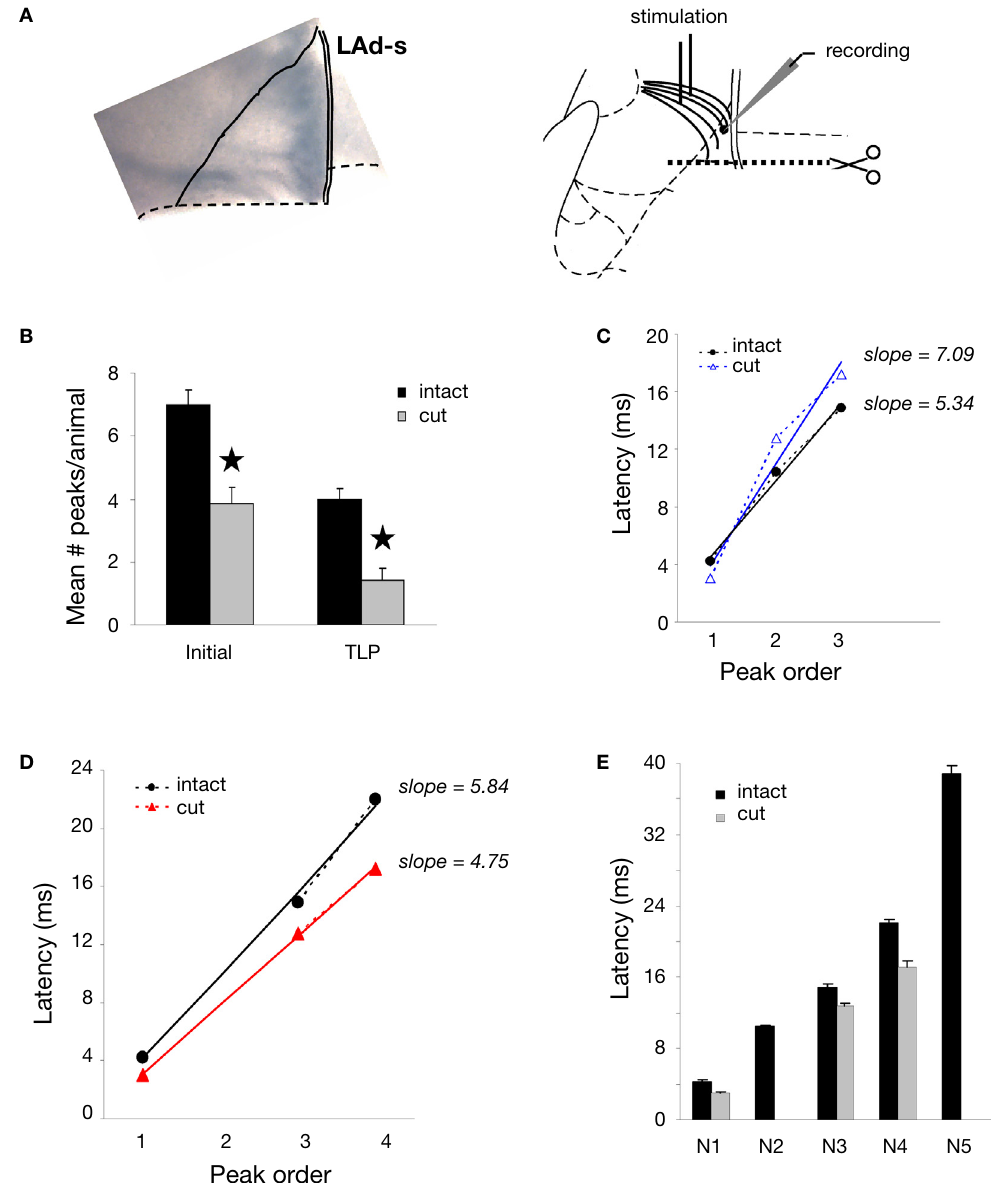
Figure 6 | Ventral origin of recurrent activity in LAd network. (A) Example of an amygdala slice cut as schematically shown, with a removal of LAd-i, ventral amygdala nuclei and overlying cortex. Recordings were made in LAd-s network with stimulation of thalamic afferents. (B) Recordings from isolated LAd-s show a signifi cant reduction in the number of polysynaptic peaks. Both the total number of peaks identifi ed (initial) with non-linear curve fi tting and the number of reliable peaks identifi ed probabilistically (TLP) were reduced ( p < 0.05) in the isolated LAd-s. (C) Extracted peak latency versus peak number shows linear rela- tions when peaks were arranged sequentially with a difference in slope of 1.75 between intact and cut preparations. (D) When extracted peaks were arranged non-sequentially, based on closest matching latency, the correlation lines showed a difference in slope of 1.09. (E) Closest latencies and linear slopes reveal that isolation of LAd-s reduced the polysynaptic network to N1, N3, and N4. Therefore, sources of TLPs N2 and N5 are located